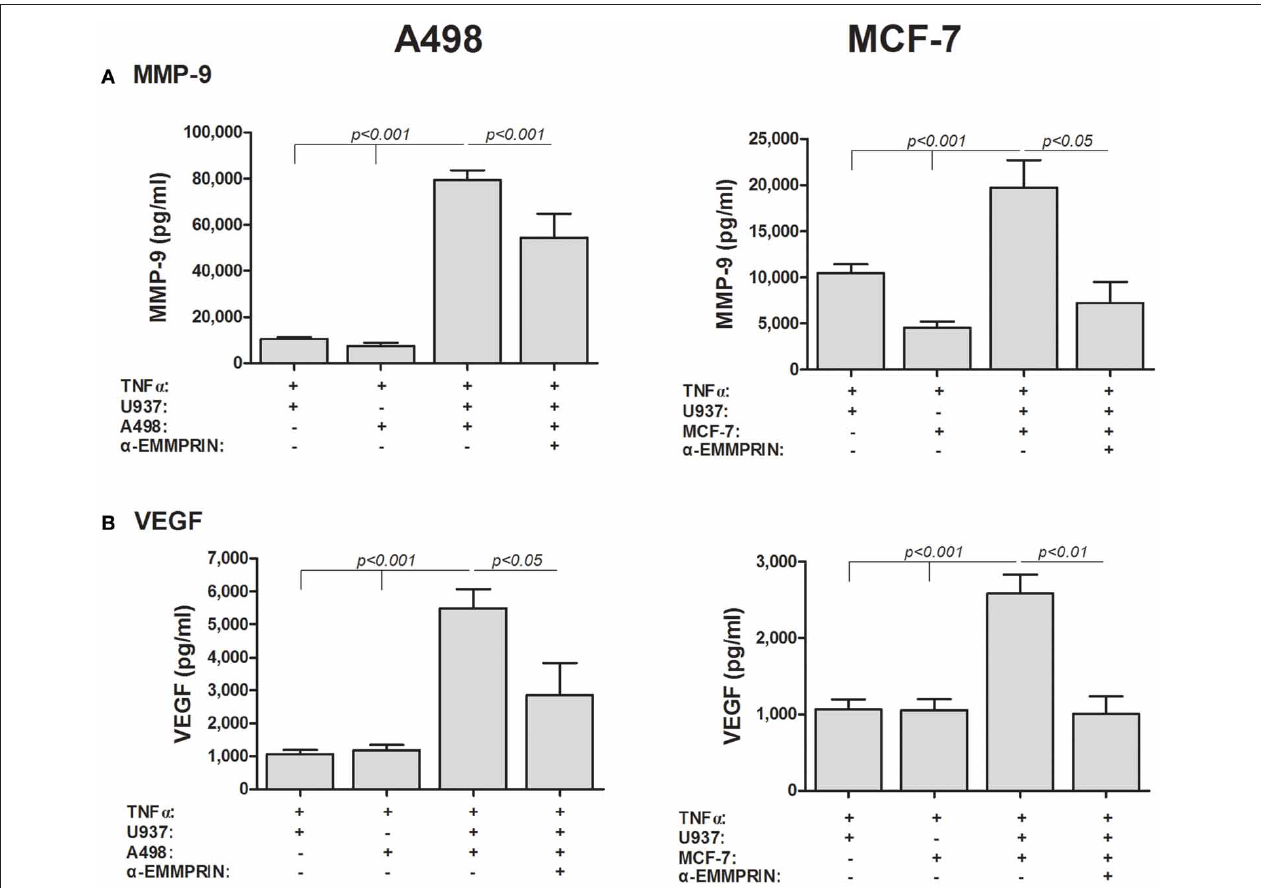
with TNF α (1ng/ml) for 48h, with or without the addition of anti-EMMPRIN (2ng/ml). Concentrations of (A) MMP-9 and (B) VEGF were determined in the supernatants using ELISA ( n =